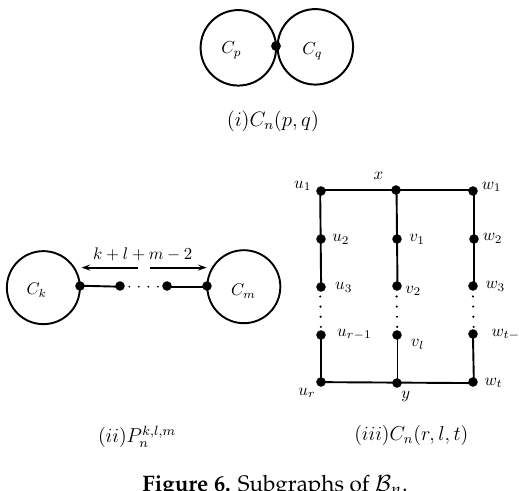
Figure 6. Subgraphs of